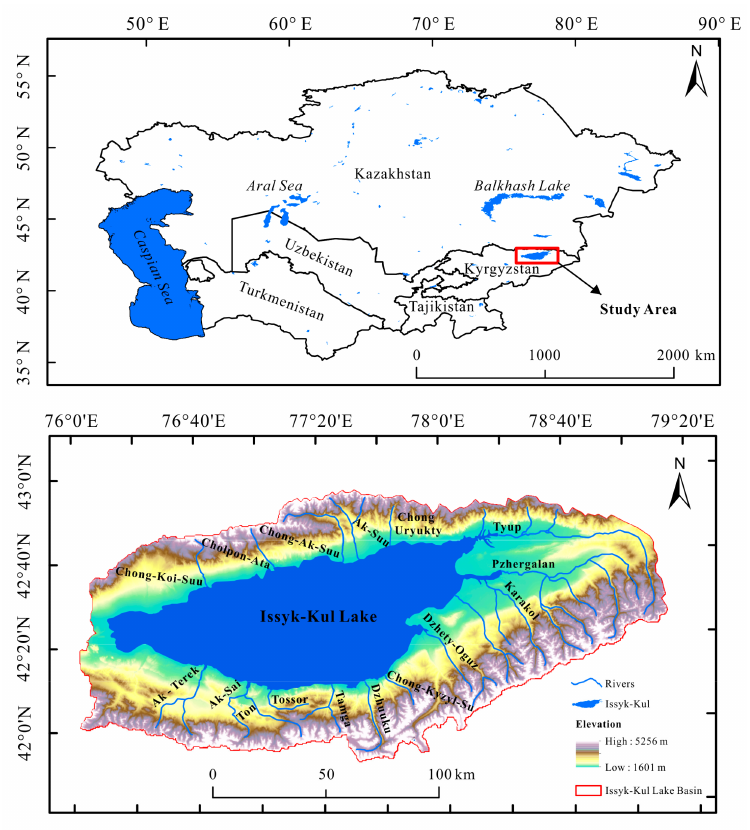
Figure 2. Location of Issyk-Kul Lake Basin, Kyrgyzstan, Central